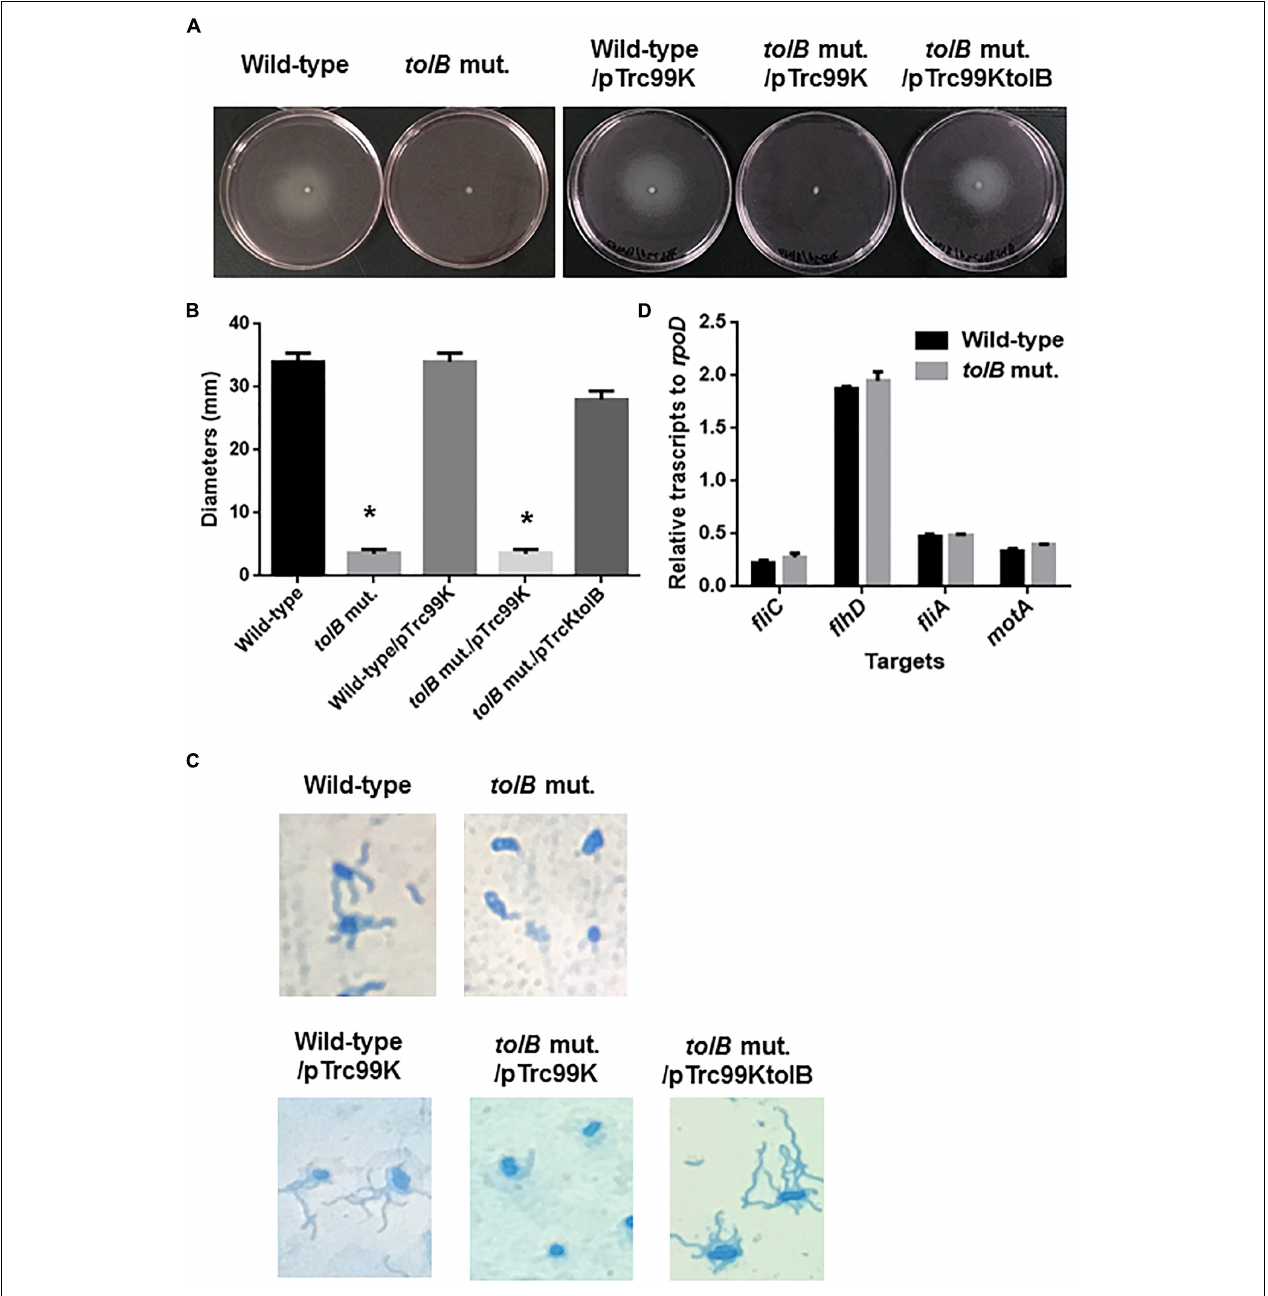
FIGURE 5 | Motilities of the wild-type parent and tolB mutant, or wild-type parent and tolB mutant carrying pTrc99K (empty vector) or pTrc99KtolB ( tolB expression plasmid). (A) Bacterial migrations on RPMI1640 medium containing 0.3% agar after 10 h at 37 ◦ C under 5% of CO 2 were pictured. (B) Bacterial migrations on the agar were represented as diameters. Data plotted are the means from three independent experiments; error bars indicate the standard deviations ∗ P < 0.01. Asterisks denote significance for values relative to the wild-type control. (C) Flagella and bacteria cells stained with Victoria blue/Tannic acid were pictured on the microscopy using 100 × objective. (D) Transcript levels of motility-related genes in the wild-type parent and the tolB mutant. Transcript levels were described as relative values to that of rpoD (housekeeping gene). Data plotted are the means of two biological replicates, error bars indicate the